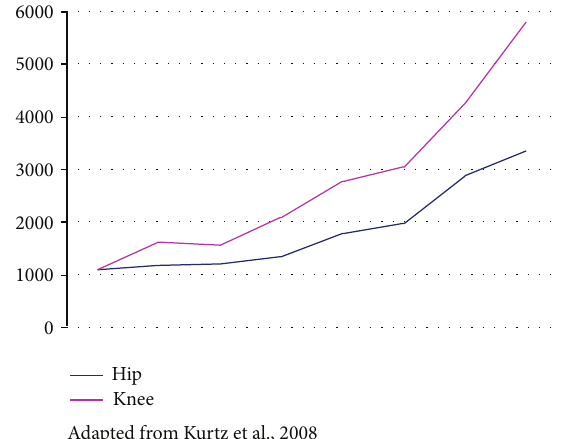
Figure 2: Evolution of the numbers of cases of prosthesis infection diagnosed in the USA between 1990 and